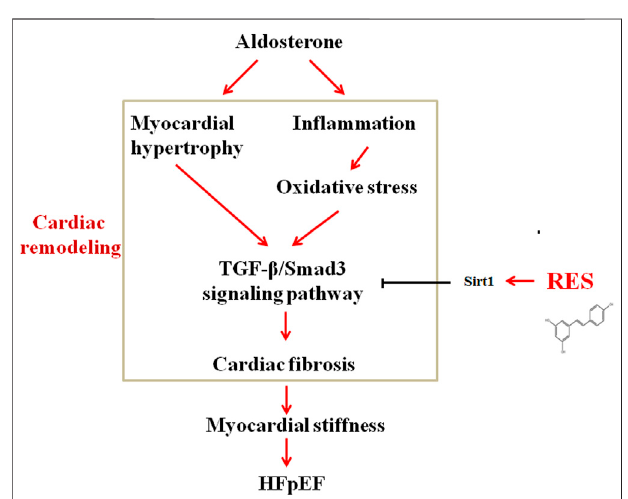
FIGURE 9 | Schematic diagram showing possible mechanisms by which aldosterone induces cardiac fi brosis in HFpEF.